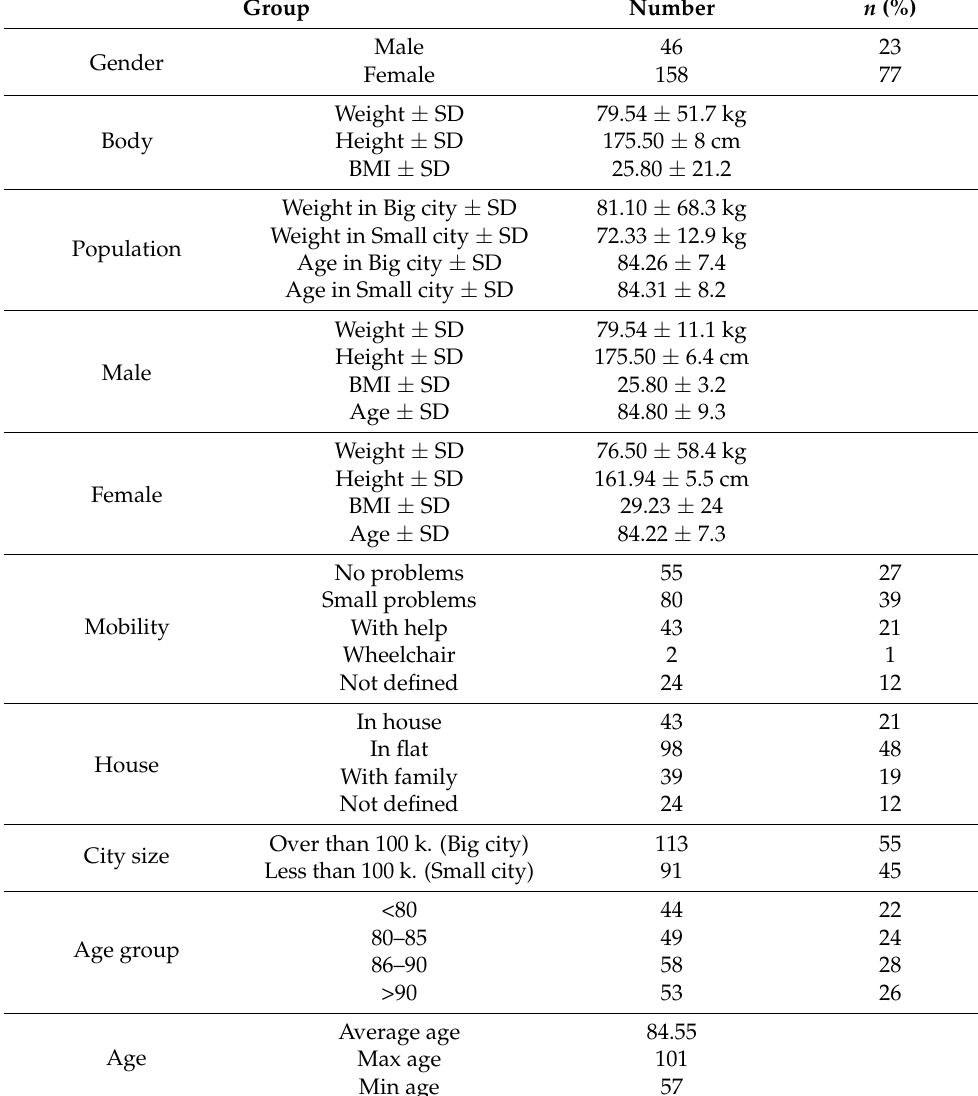
Table 1. Demographic data about the 204